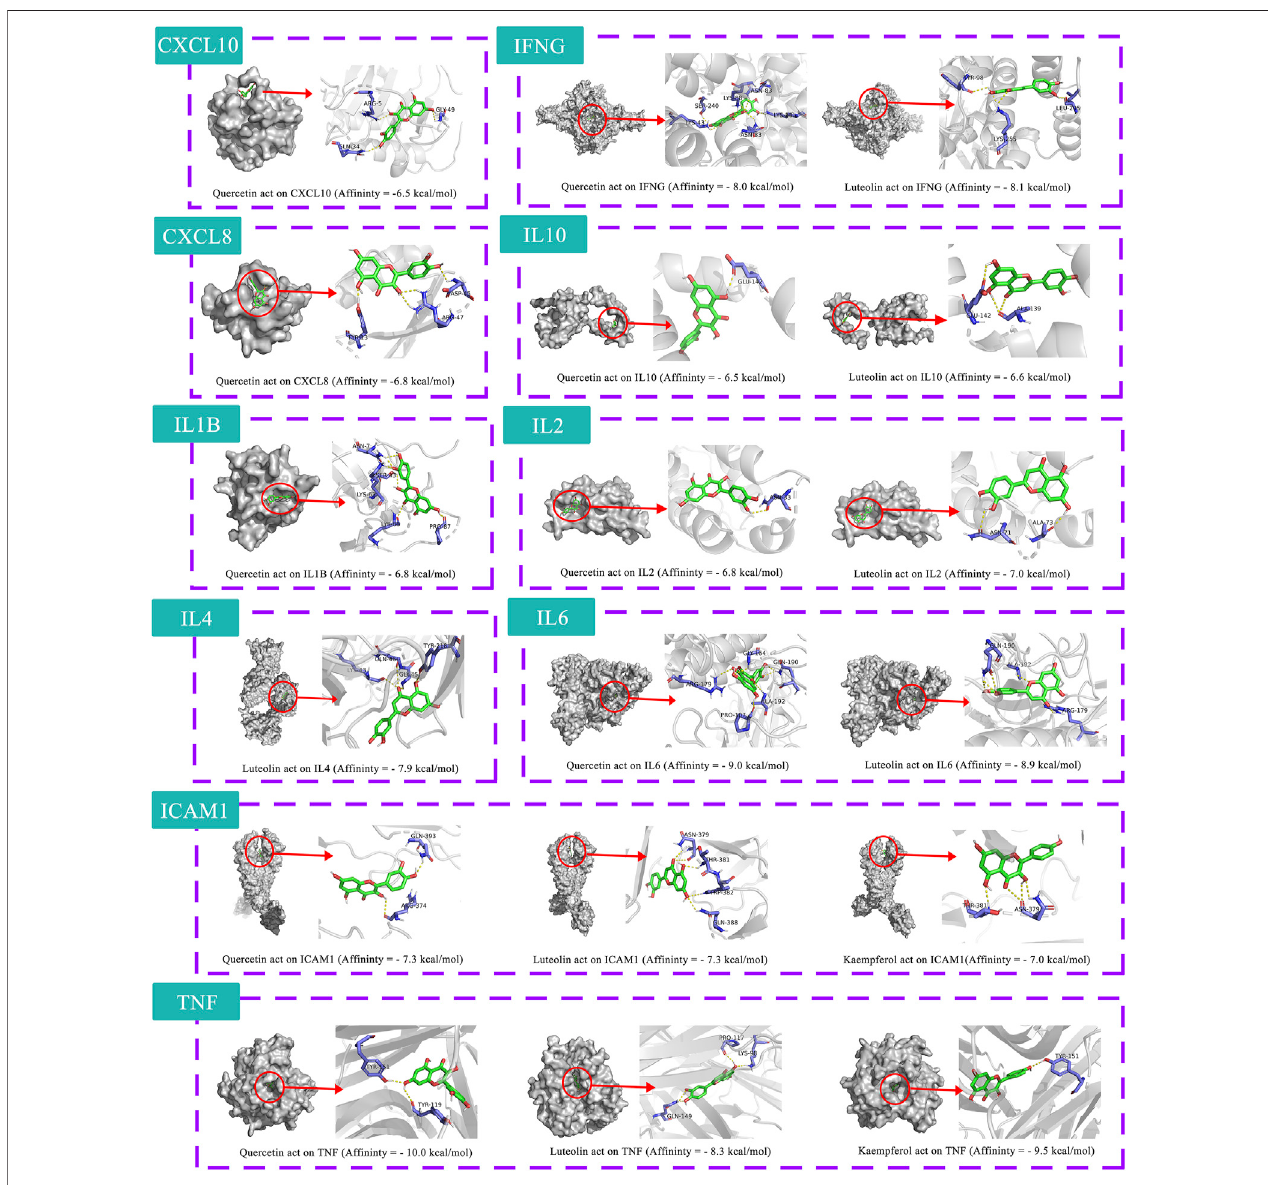
FIGURE 5 | Molecular docking